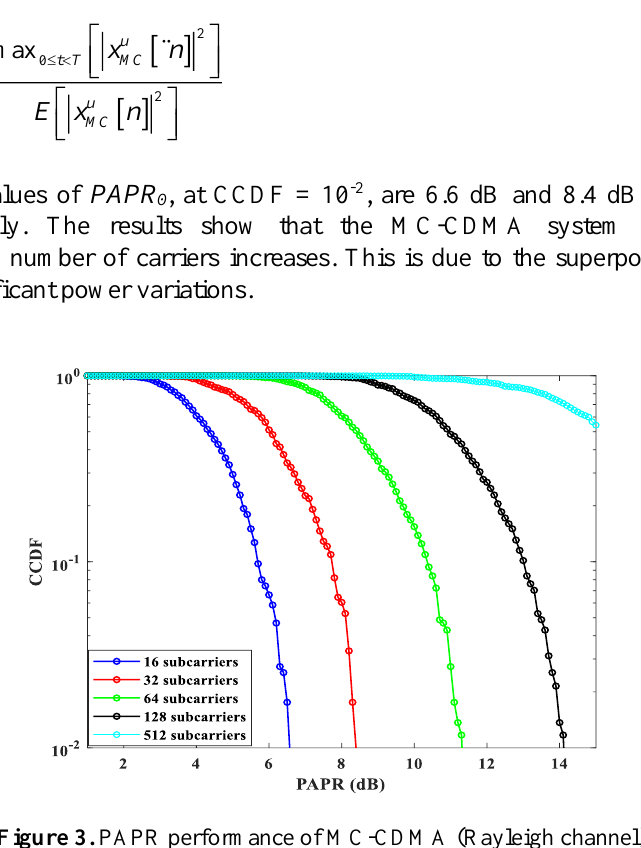
Figure 3. PAPR performance of MC-CDMA (Rayleigh channel).